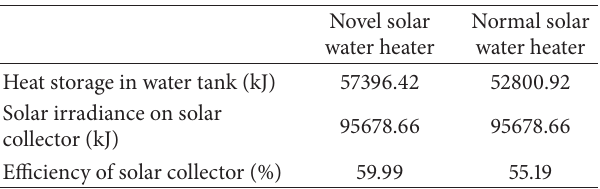
Table 1: Comparison of the two solar water heater’s heat perfor-